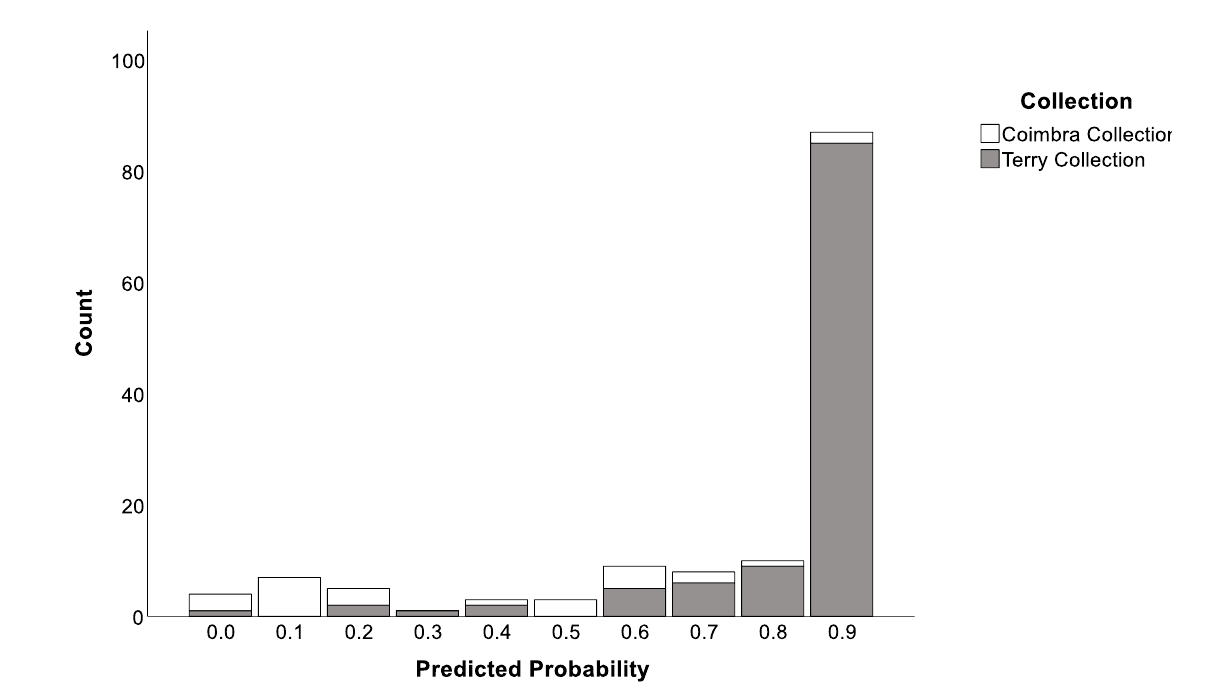
Figure 2. Distribution of p -values for the all-sexes Terry collection sample (n = 111) and the entire all-sexes Coimbra collection sample (n = 127).